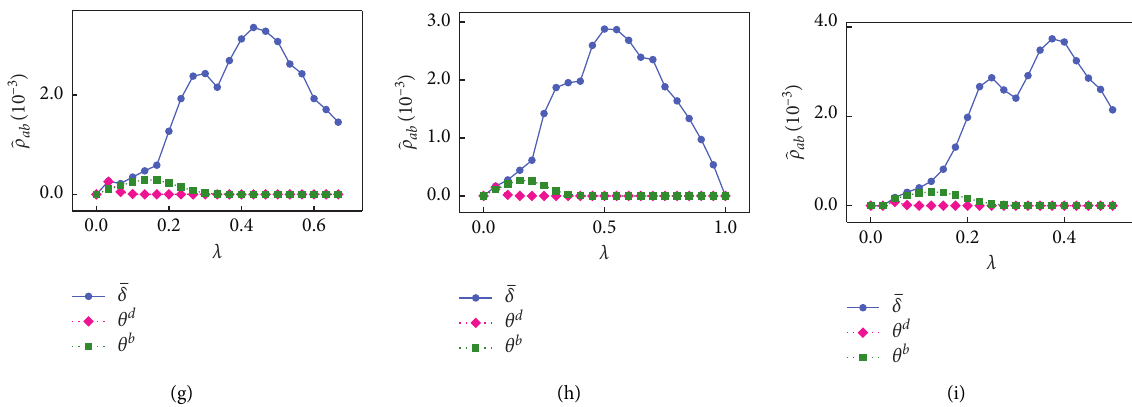
Figure 4: Incremental cooperative spreading prevalence 􏽢 ρ ab after adding the optimal latent edge to the real-world networks. The incremental cooperative spreading prevalence 􏽢 ρ ab after adding the optimal latent edge scored by δ (blue circles), product θ d (pink diamonds), or θ b (green squares) to the real-world network Jazz musicians [54] when (a) β � 1, (b) β � 1 . 5, and (c) β � 2. The corresponding results of real-world network physicians [54] and inf-USAir97 [55] are shown in (d) β � 1, (e) β � 1 . 5, and (f) β � 2 and (g) β � 1, (h) β � 1 . 5, and (i) β � 2,